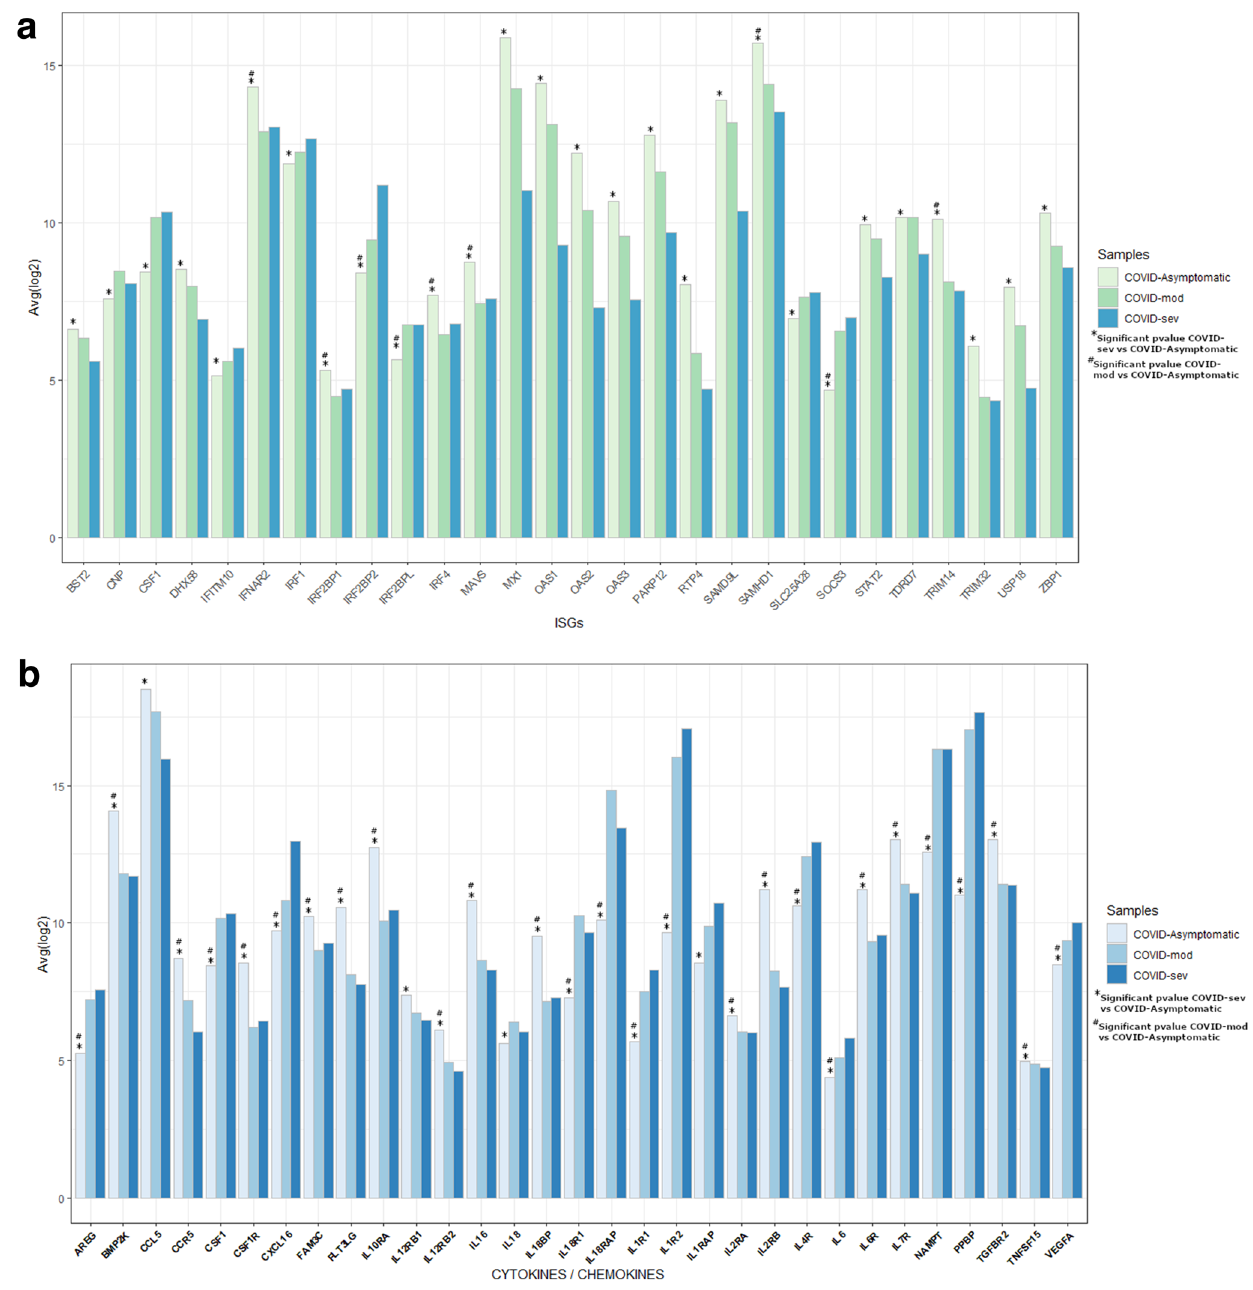
Figure 6. Differential activation of Interferon and cytokine genes across the COVID-19 severity spectrum. ( a ) Histogram of Interferon stimulated genes (ISGs) plotted on x-axis against avg(log2) values for severe (COVID- Sev), mild (COVID-Mild) and Asymptomatic (COVID-Asymp) cases. Higher avg(log2) values are exhibited by IFNAR2, MX1, OAS1 and SAMHD1. ( b ) Histogram of Cytokines/Chemokine genes plotted on x-axis against avg(log2) values for severe (COVID-Sev), mild (COVID-Mild) and Asymptomatic COVID-19 (COVID- Asymp). Higher avg(log2) values are exhibited by CCL5, IL1R2, NAMPT and PPBP. Significant p-values of COVID-Sev vs COVID-Asymp is labelled by * and significant p-values of COVID-Mod vs COVID-Asymp is donated by